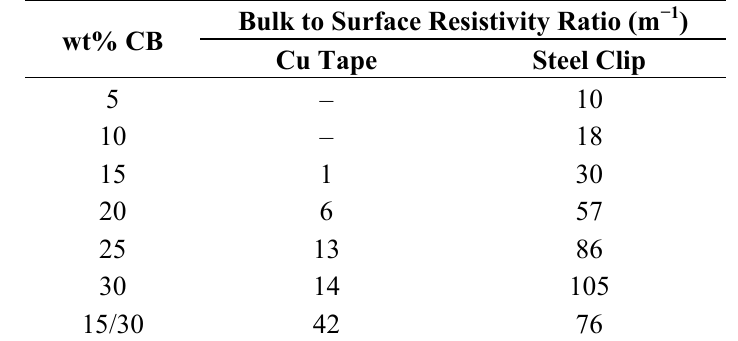
Table 1. Ratio between the experimentally determined bulk and surface resistivities as a function of wt% carbon black